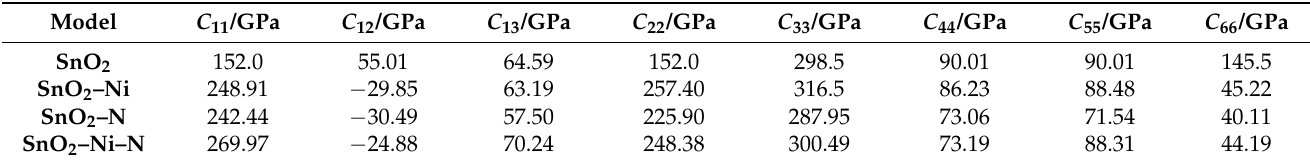
Table 3. Elastic